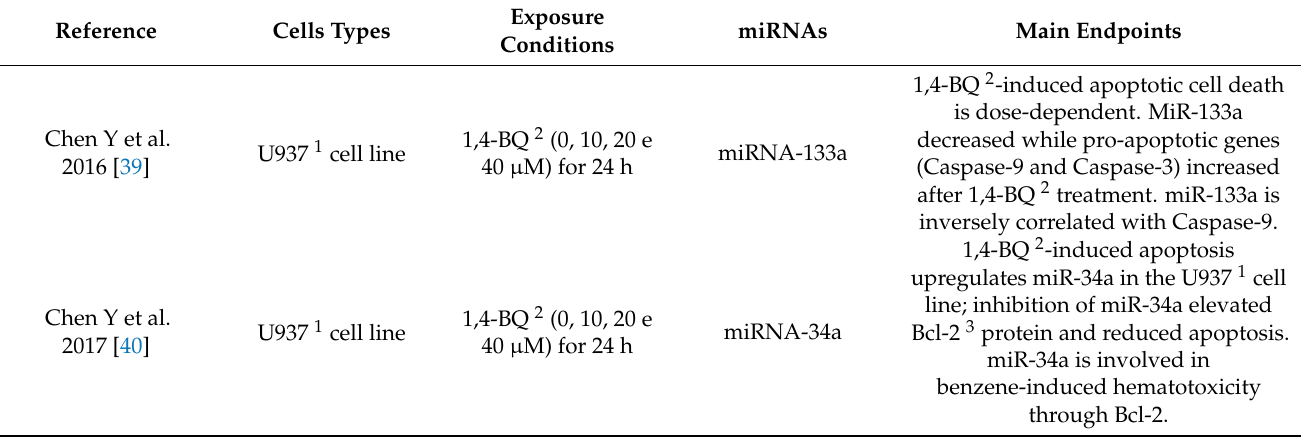
Table 1. The main outcomes from in vitro